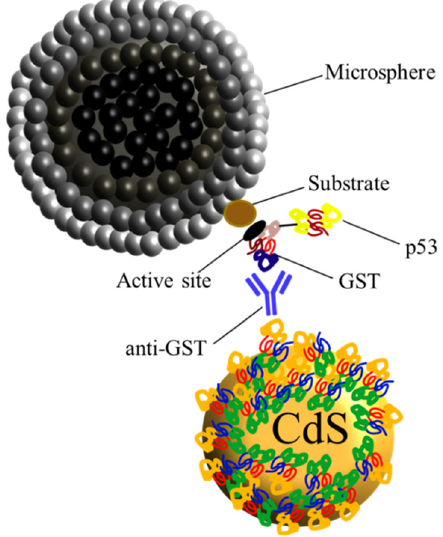
Figure 11. Schematic representation of super-paramagnetic microsphere (black) interaction by a glutathione group (brown), with the active site of the GST enzyme, expressed by IVTT system. New synthetized protein (GST-tagged) is caught by the α -GST antibody (blue) previously conjugated to the novel QD.